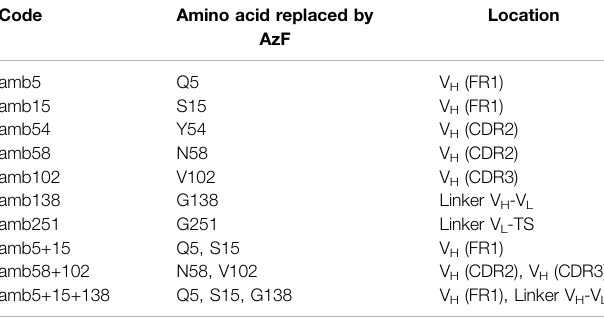
TABLE 1 | Nomenclature of panitumumab scFv amber mutants and ncAA location.